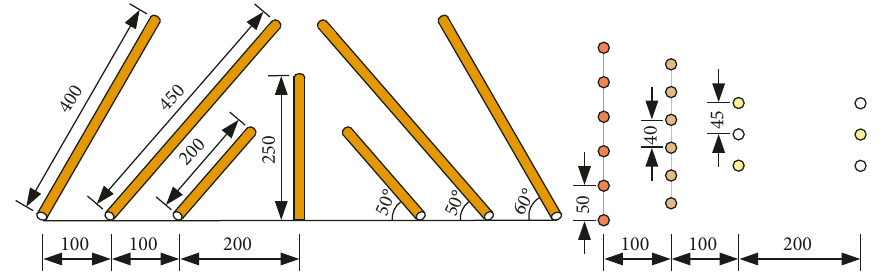
Figure 10: Layout of multistage double wedge groove (unit: